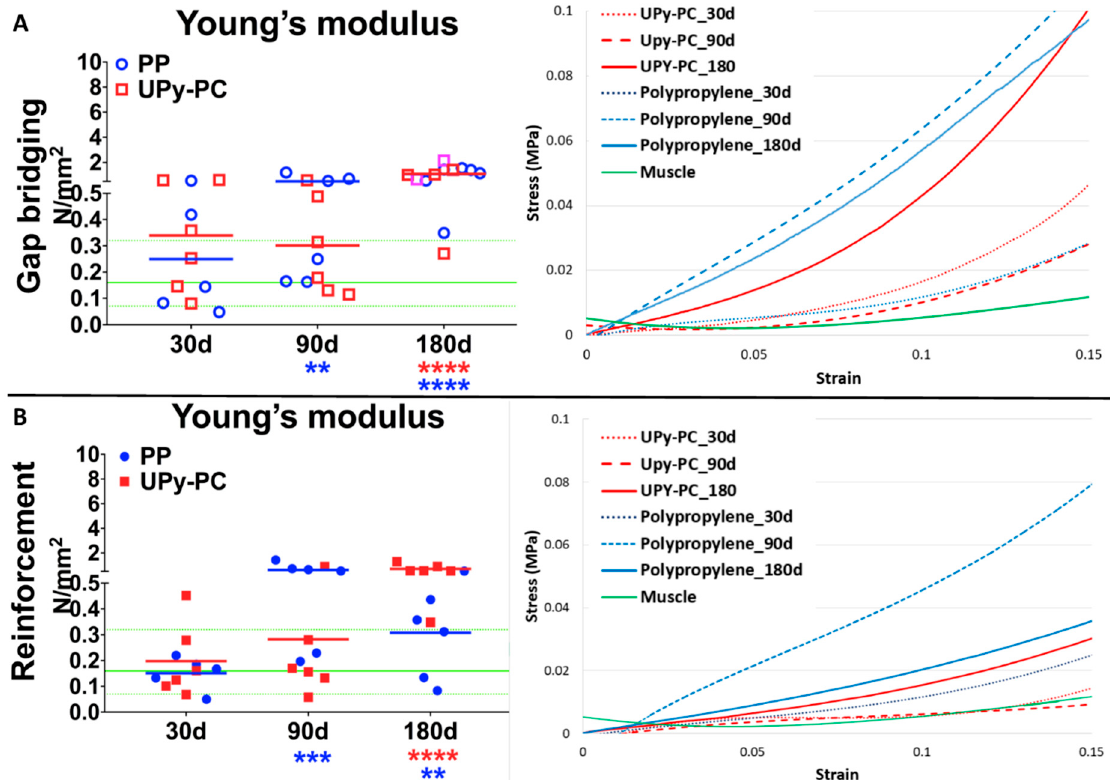
Figure 1. Biomechanical analysis. The left panels display the individual observations of Young’s modulus in the comfort zone of the abdominal wall explants of rabbit after implantation using polypropylene (PP, blue) or UPy-PC (red) in a gap bridging ( A ) and reinforcement ( B ) hernia model. The horizontal green full and dotted line represents the mean, the minimum, and the maximum values of native muscle tissue (NM). The right panels display the curves of stress–strain in the range of 0–20% of elongation. Gap briding: PP was stiffer than native muscle tissue (NM) at 90 and 180 days and UPy-PC was stiffer than NM at 180 days. The compliance of UPy-PC explants where herniation was present fell in the same range as the ones without. Reinforcement: PP showed a significantly stiffer abdominal wall than that of NM at 90 and 180 days and UPy-PC was significantly stiffer than NM at 180 days. Blue (PP) or red (UPy-PC) asterisks represent the difference compared to native tissue. ** p ≤ 0.01,*** p ≤ 0.001 and **** p ≤ 0.0001. Herniated samples are marked by a lighter colour (pink). PP: Polypropylene; UPy-PC: electrospun ureidopyrimidinone polycarbonate.